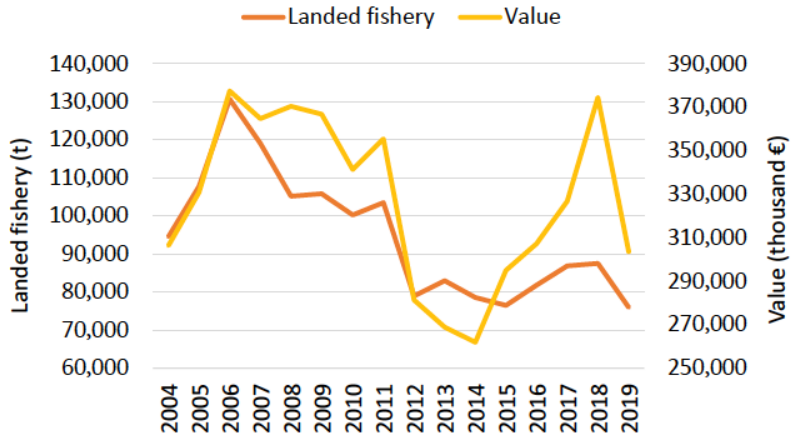
Figure 4. Evolution of the landed fishery (live weight) and its value in the Spanish Mediterranean (2004–2019). Annual average values 6 .